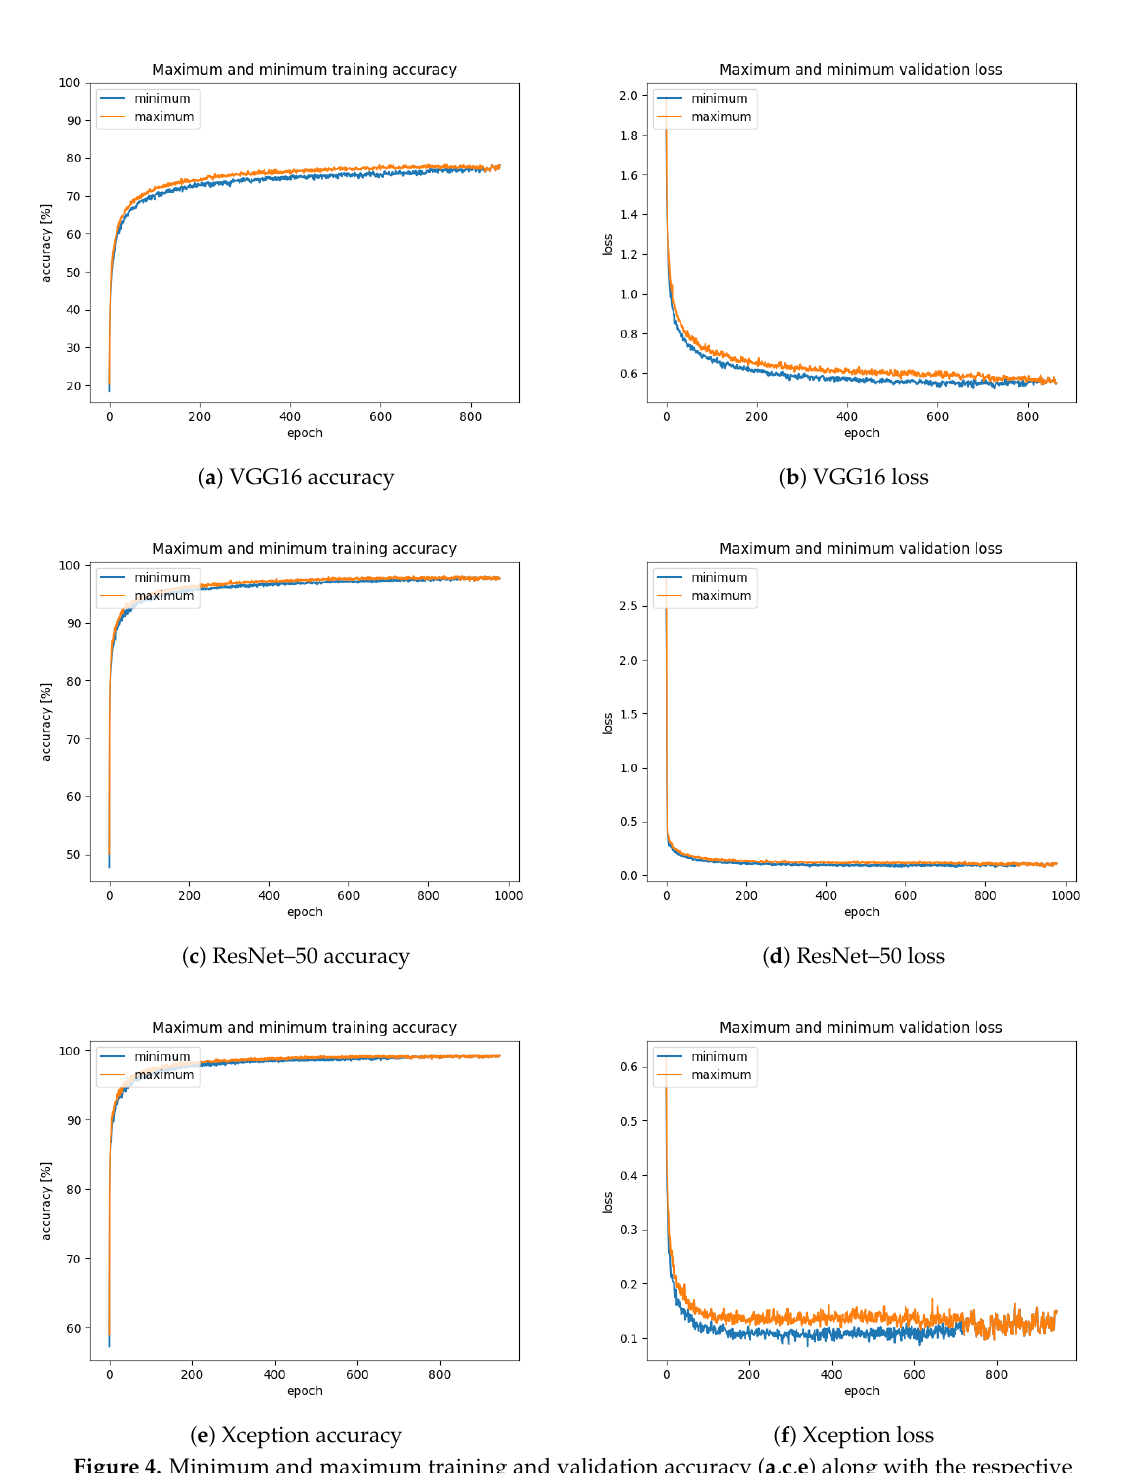
Figure 4. Minimum and maximum training and validation accuracy ( a , c , e ) along with the respective training and validation loss ( b , d , f ) over the ten repetitions performed for ( a , b ) VGG16, ( c , d ) ResNet–50, and the ( e , f ) Xception Convolutional Neural